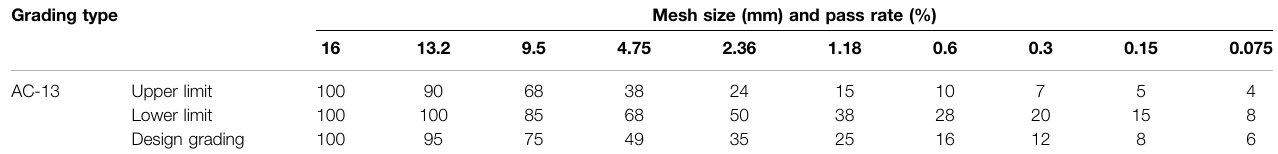
TABLE 4 | Design gradation of two kinds of asphalt mixtures. Grading type